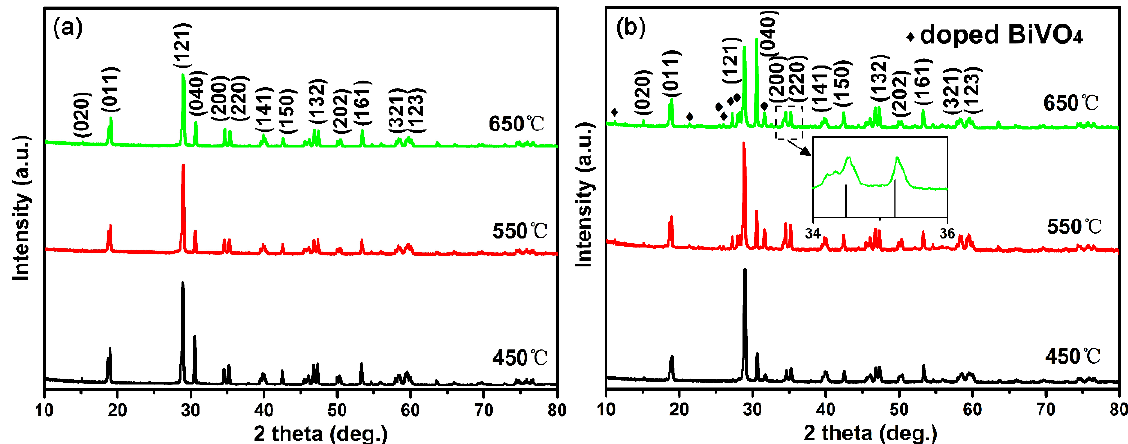
Figure 1. ( a ) XRD patterns of BiVO 4 and ( b ) Ag/BiVO 4 coatings obtained at different annealed tem- Figure 1. ( a )XRDpatternsofBiVO 4 and( b )Ag/BiVO 4 coatingsobtainedatdifferentannealedtemperatures. peratures. Comparing BiVO 4 and Ag/BiVO 4 coatings with the corresponding standard